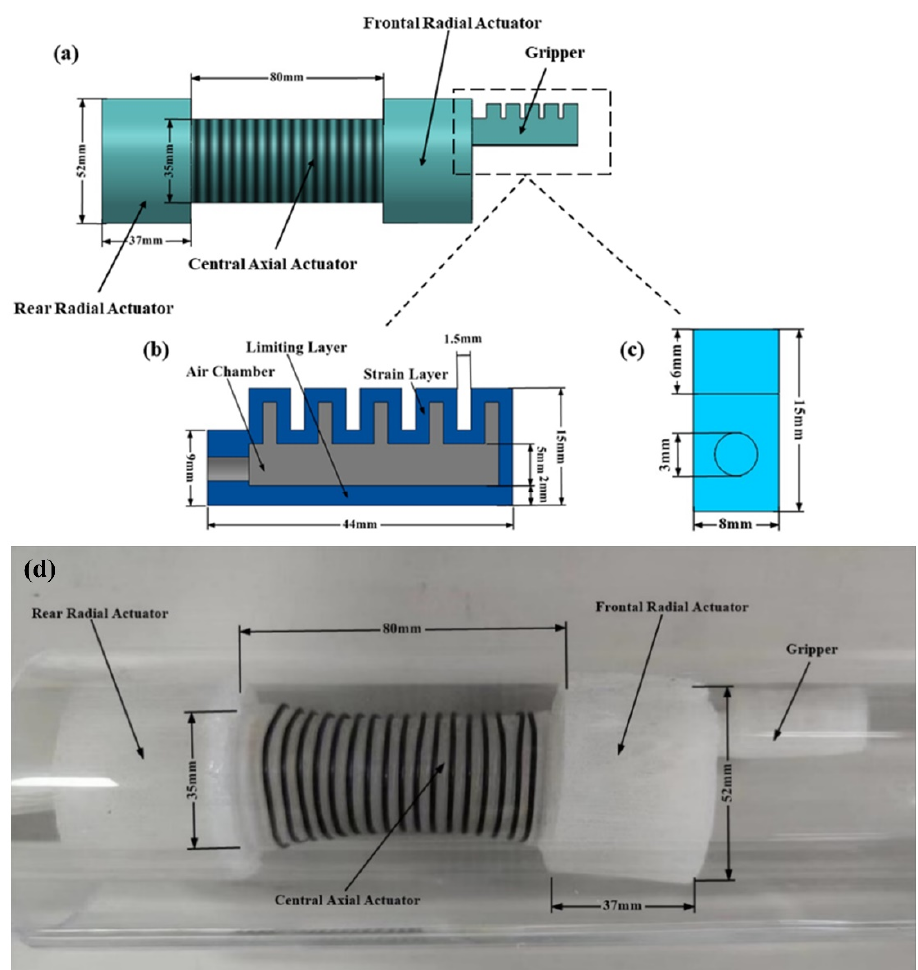
Figure 1. The structure and size of the intestinal soft robot. ( a ) The dimensional diagram of the intestinal soft robot. ( b ) Frontal view of the gripper. ( c ) Side view of the gripper’s structure. The round hole is used to insert the silicone tube into the air chamber of the gripper. The wall thickness is 2 mm. ( d ) Prototype of the intestinal soft robot.